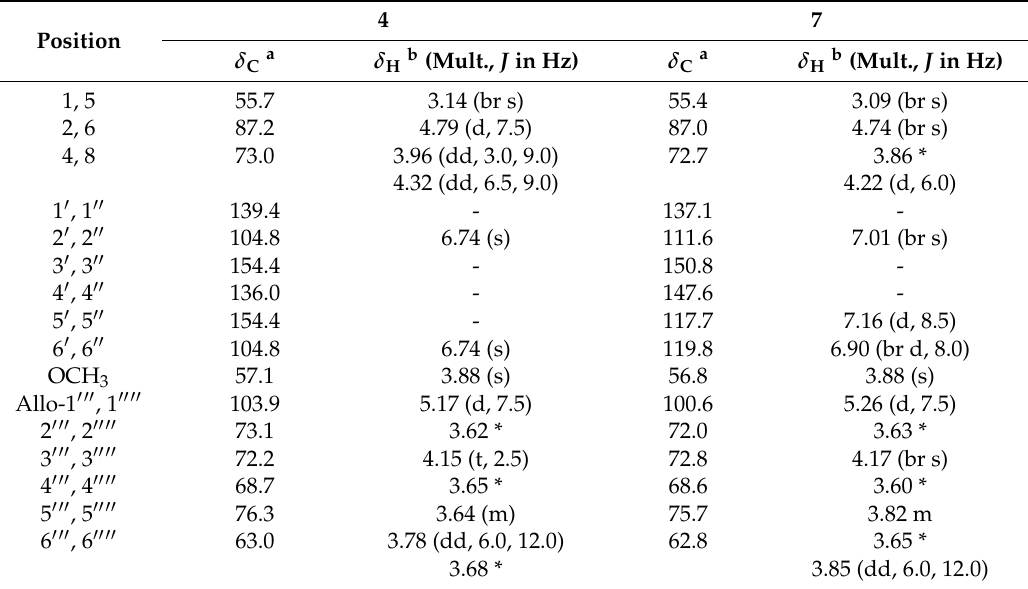
Table 2. 1 H- and 13 C-NMR Data of 4 and 7 in CD 3